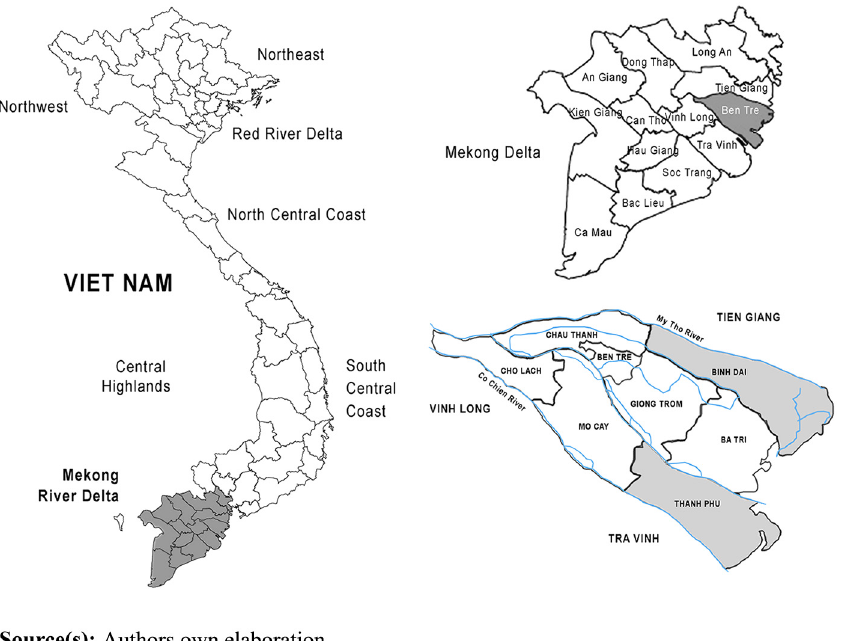
Figure 1. Study area of Binh